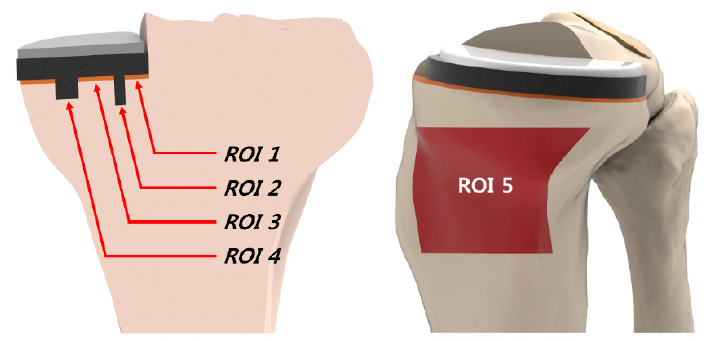
Figure 3. Five locations for the interests of this study.